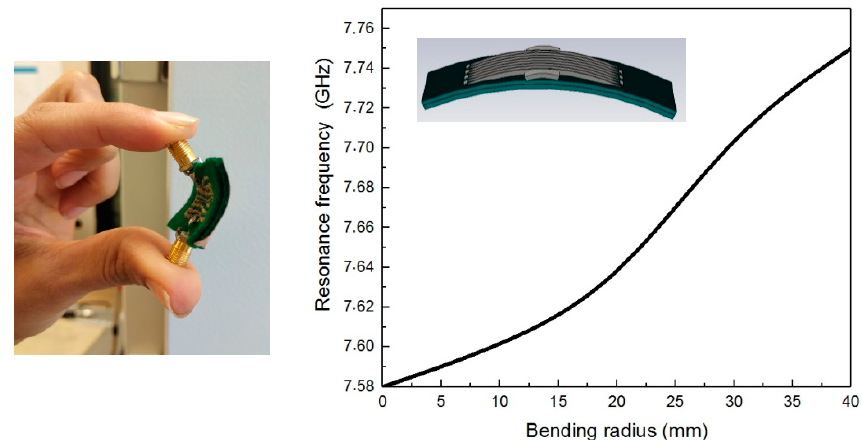
Figure 5. Simulated effect of bending the wearable filter with different radii: 10, 30, and 40 mm. It is observed that by changing the bending radius to 40 mm, the resonant frequency was shifted up 4.25 MHz/mm